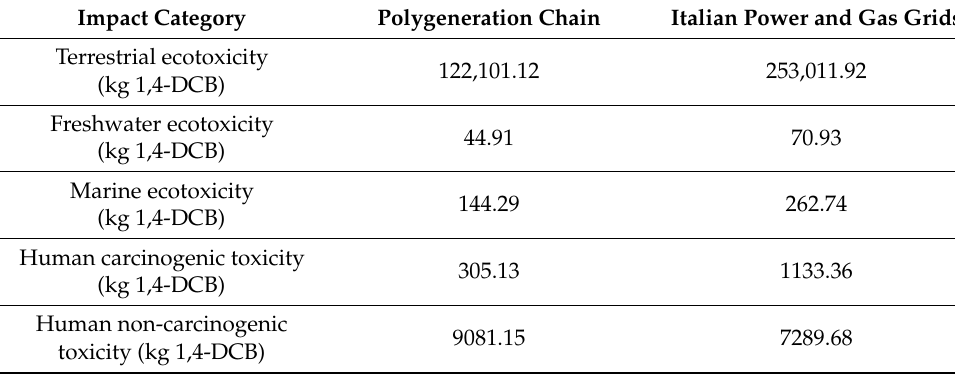
Table 3. ReCiPe midpoint—characterisation—polygeneration chain and Italian grids.